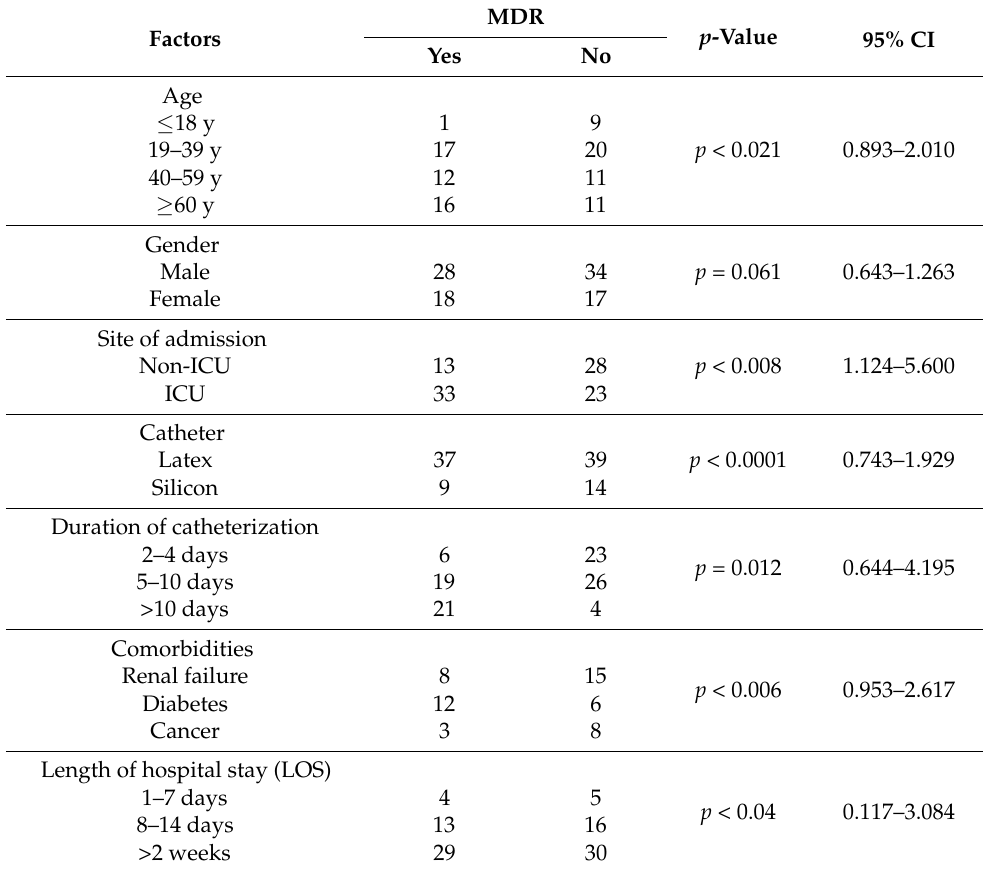
Table 1. Factors associated with CA-UTI caused by